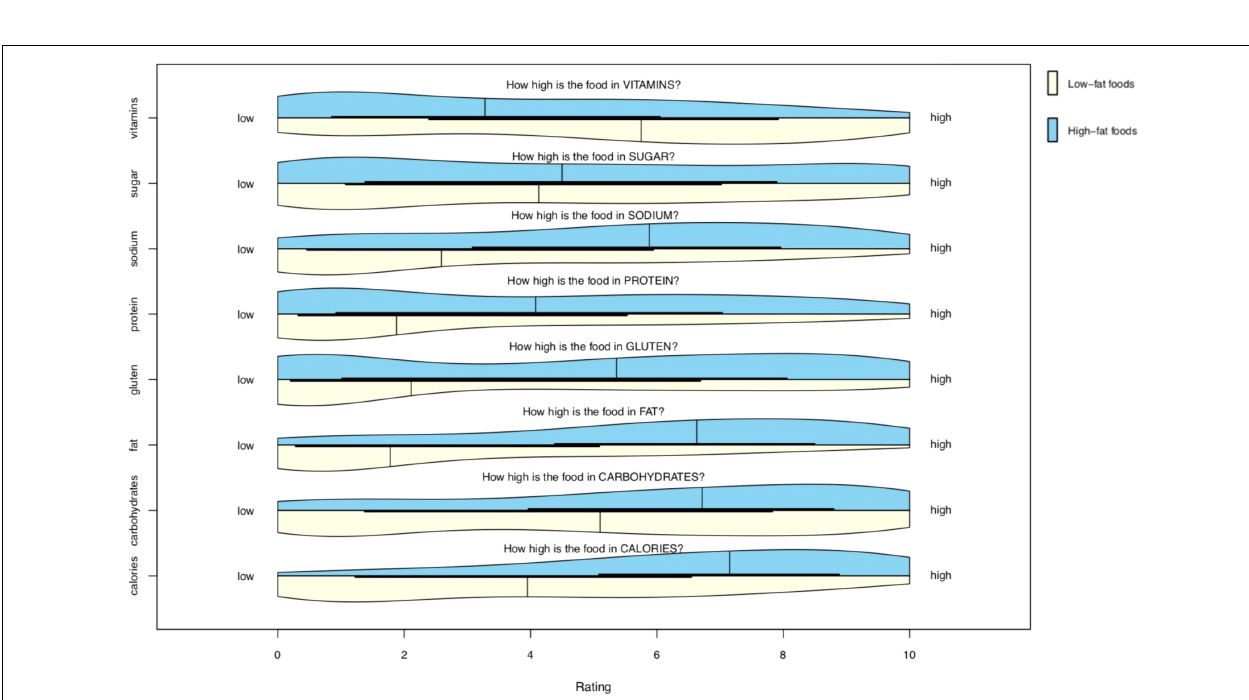
FIGURE 4 | Probability distribution plot of estimated nutritional content ratings. Plots show the distribution of scores for each rating of nutritional content across the collection of low-fat (lower/yellow) and high-fat (upper/blue) foods of the stimulus set. Every rating (for each of the 46 foods, from all 1,054 participants) is included. N ratings for low-fat foods = 25,647; n ratings for high-fat foods = 22,862.